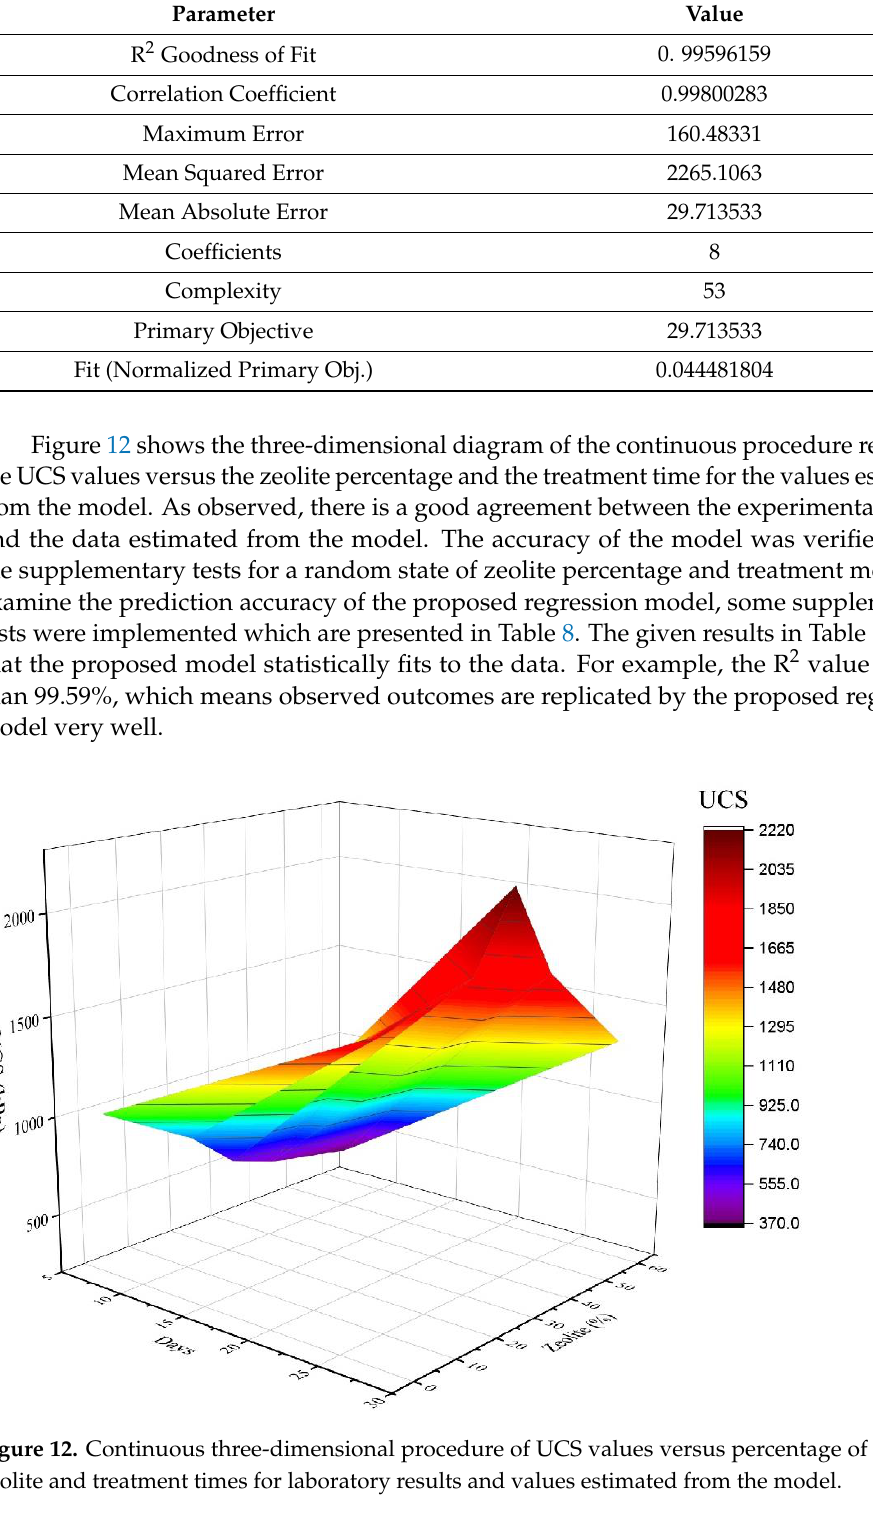
Table 8. Statistical analysis of the model fitted to the unconfined compressive strength data.